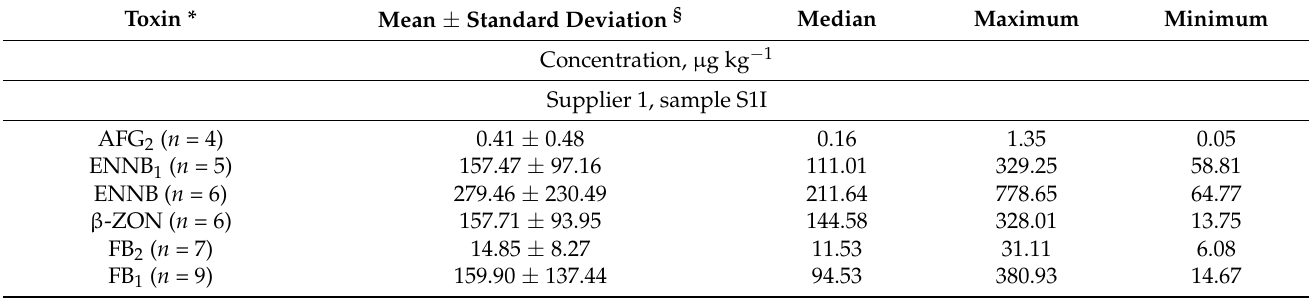
Table 4. Descriptive analysis of toxins found over time in two batches of animal feed stored in the